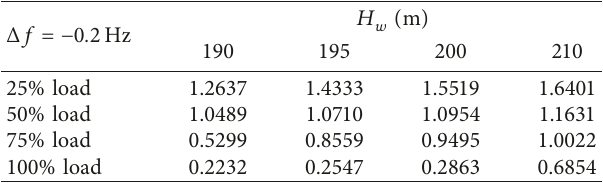
Table 8: The comprehensive ITAE Index when Δ f � − 0 . 2Hz. Δ f � − 0 .